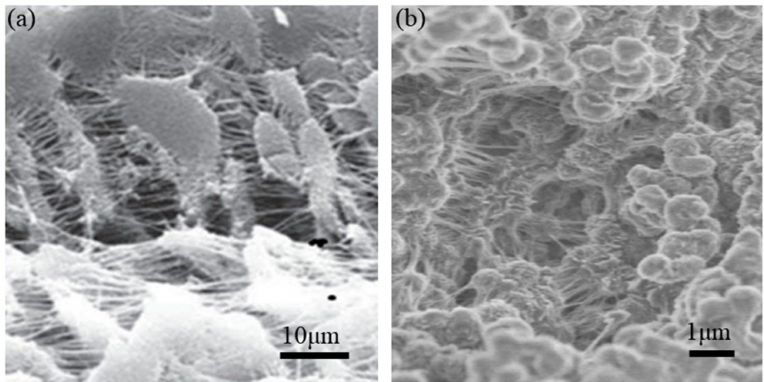
Figure 14. ( a ) Scanning electron microscope (SEM) image of the microstructure of polytetrafluroethylene (PTFE). ( b ) Low vacuum scanning electron microscopy (LVSEM) micrograph of GUR ® 1050 ultra-high molecular weight polyethylene (UHMWPE) powder showing fibrils and nodules of approximately 1 µ m size [79–81].